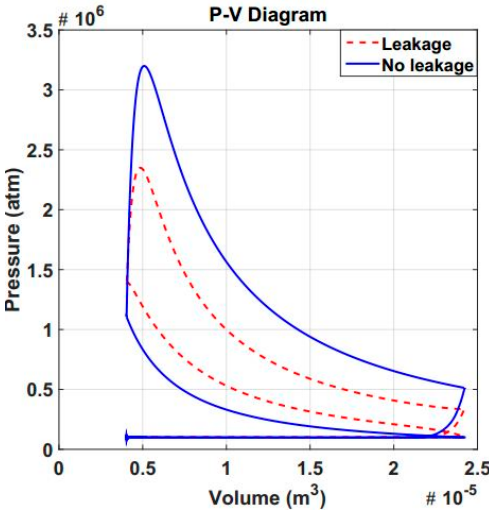
Figure 15. P-V diagram over one cycle (30 Hz).